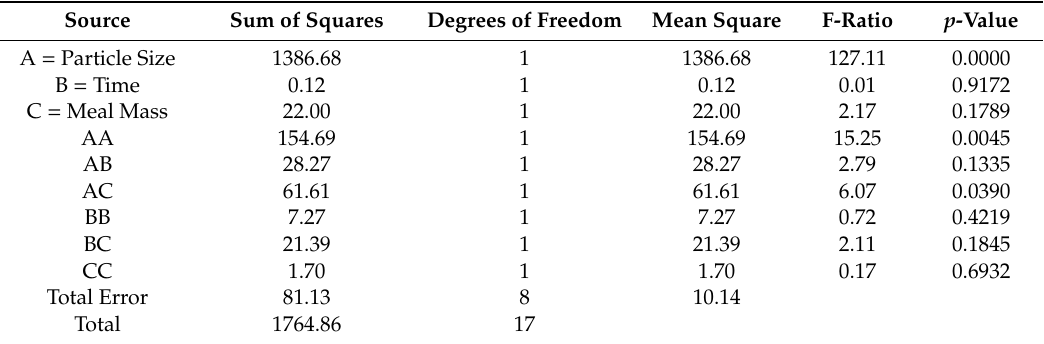
Table 5. Initial ANOVA for the response surface experiment.